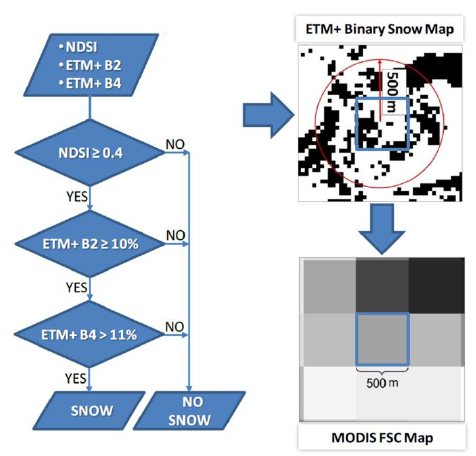
Figure 2: Derivation of reference MODIS FSC maps from binary-classified higher resolution Landsat ETM+ images.